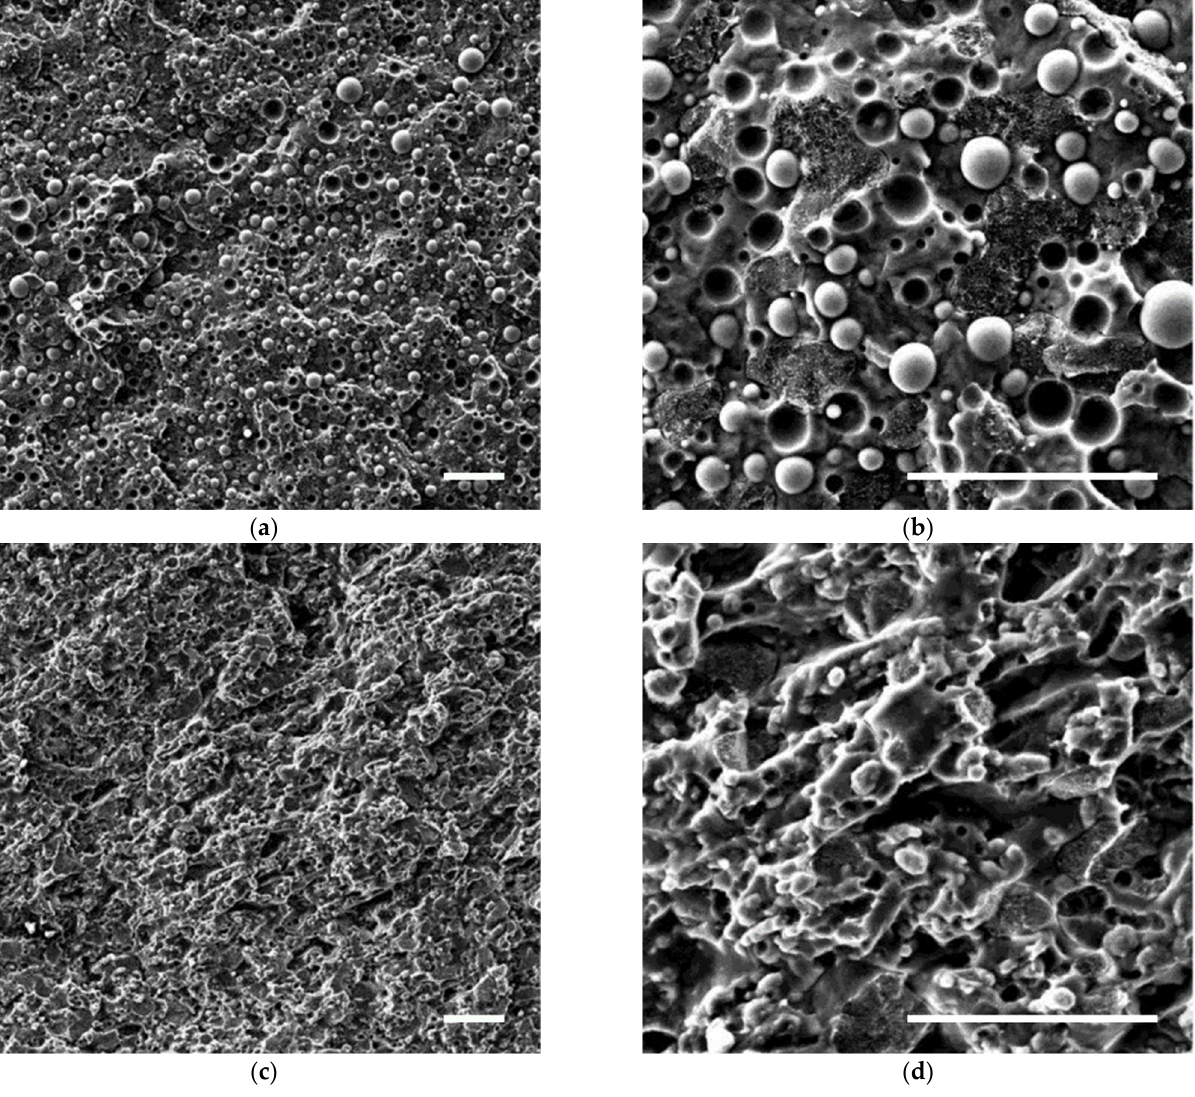
Figure 1. SEM micrographs of ( a , b ) unfilled and ( c , d ) C15A-filled HDPE/PP/PET blends at different magnification. Scale bars represent 50 µm.